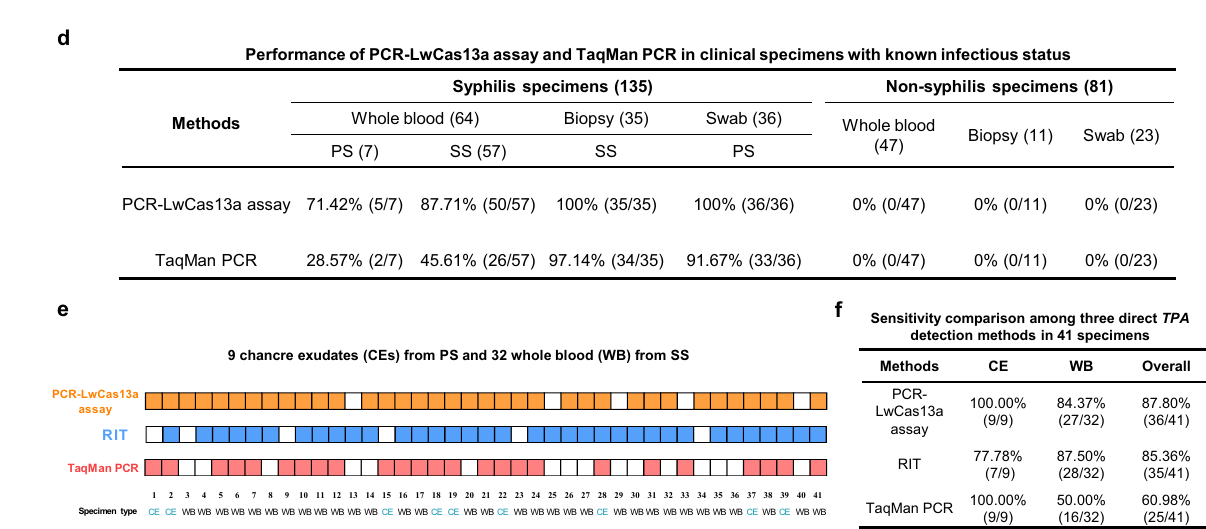
Fig. 2 | Robust performance of the PCR-LwCas13a assay for detection of Tre- ponema pallidum in clinical specimens. a The PCR-LwCas13a assay exhibits excellent detection of the tpp47 gene and is an order of magnitude more sensitive than TaqMan PCR. b Evaluation of the speci fi city of the PCR-LwCas13a assay by testing DNA from a group of 10 genital microorganisms in 180min of kinetics analysis. c Samples from 135 syphilis and 81 non-syphilis patients (216 total) were used todeterminethe clinicalsensitivityand speci fi cityofthePCR-LwCas13aassay in a parallel comparison with TaqMan PCR. Rabbit-infectivity testing (RIT) was performed on 9 chancre exudates and 32 whole blood samples from secondary syphilis. d Performance of the PCR-LwCas13a assay and TaqMan PCR with clinical specimens. e Comparison of direct detection with whole blood from 32 patients